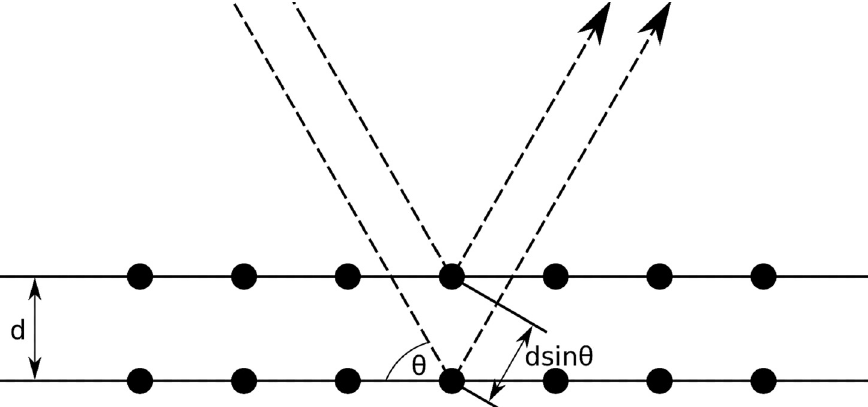
Figure 16. An illustration of Bragg reflection where the dots represent the atoms of a crystal lattice with inter-planar separation distance of d, and the dotted lines represent the impinging and scattered X-rays after interacting with the lattice.